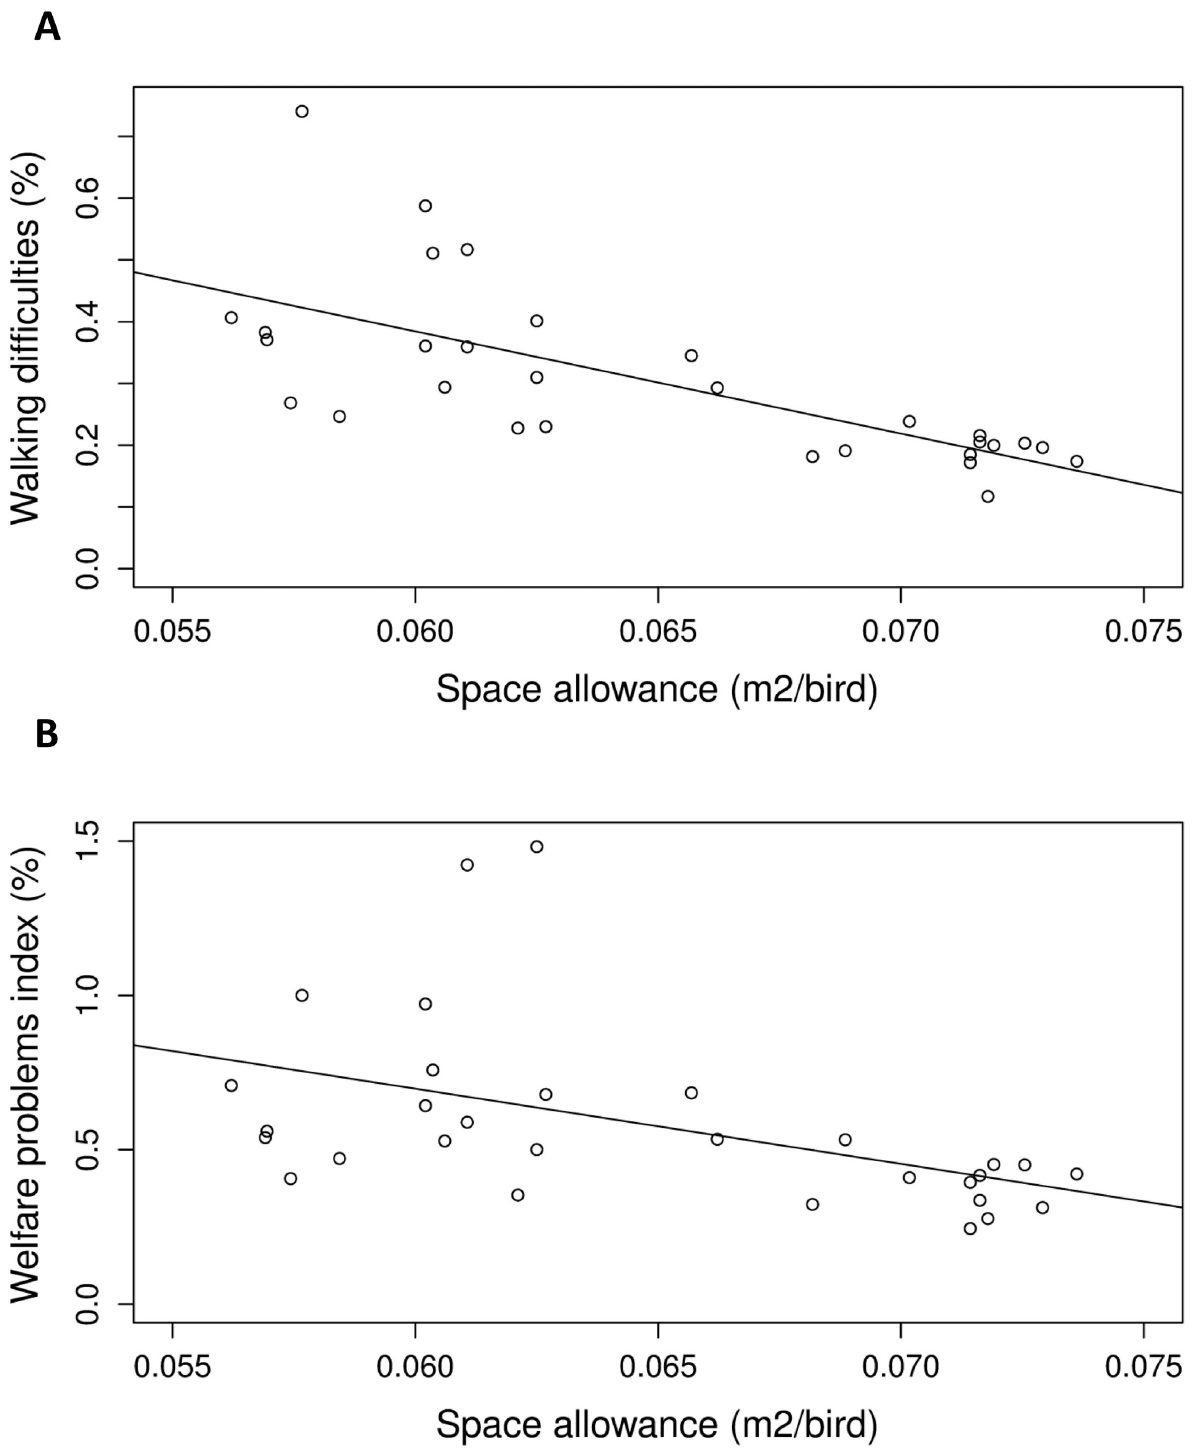
Fig 3. Associations of space allowance (m 2 /bird) with (A) walking difficulties (r 2 = 0.480) and (B) welfare problems index (r 2 = 0.233). Data points are back-transformed estimates from analysis of residuals of space allowance regressed on environmental complexity. (A) Birds detected with walking difficulties as a % of estimated number of birds in 4 assessed transects. (B) Sum of birds detected with welfare problems (walking difficulties, illness, skin wounds, small size), as a % of the estimated number of birds in 4 assessed transects.